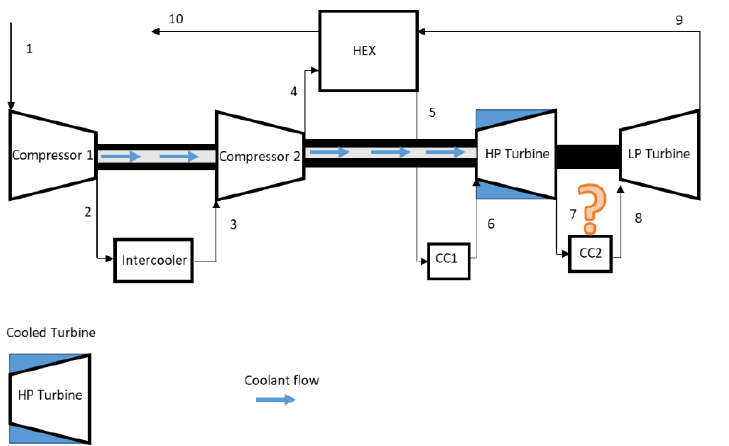
Figure 9. IRReGT cycle with a cooled HP turbine. (Numbers 1-10 describe the flow passage at different stage of the cycle).